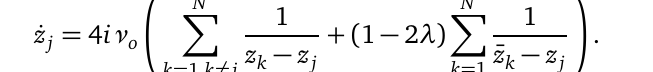
Figure 7: Dynamics of the two poles given by Eq.148 in the complex plane with time as the parameter. We have set ν (Blue), C = 0.5(Red) and C = 0